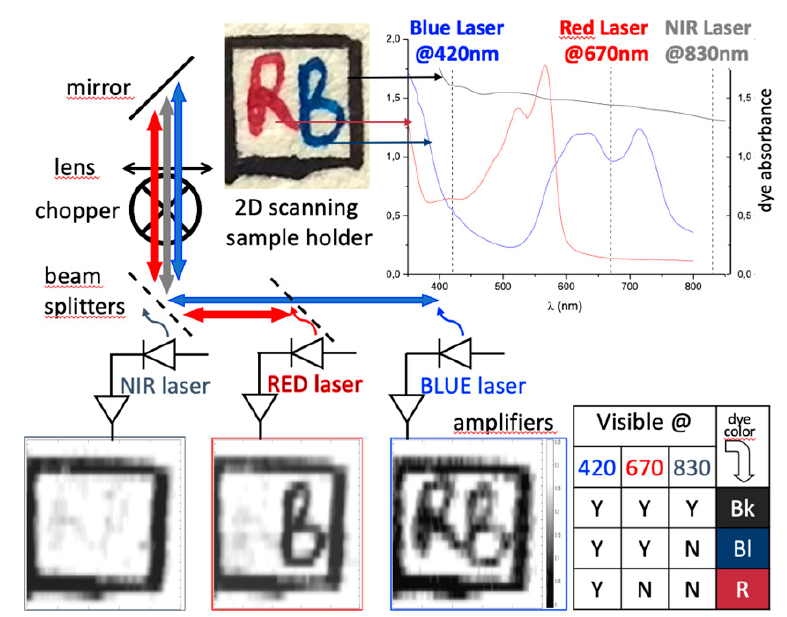
Figure 11. Graphic abstract of the experimental outcome. The lookup table at bottom-right helps to identify the color distribution on the target. (adapted from Reference [41])